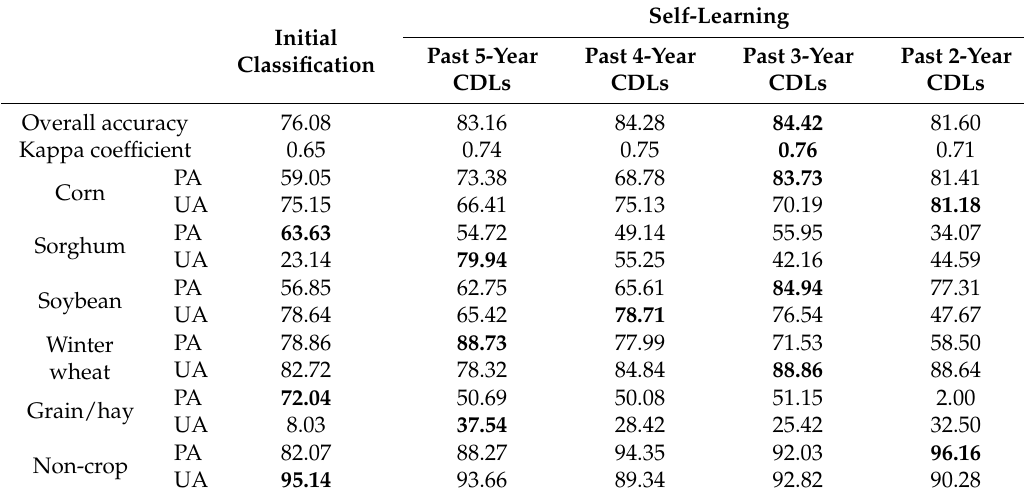
Table 6. Comparison of the accuracy statistics for the different classification results. UA and PA denote user’s accuracy and producer’s accuracy, respectively. The best case is shown in